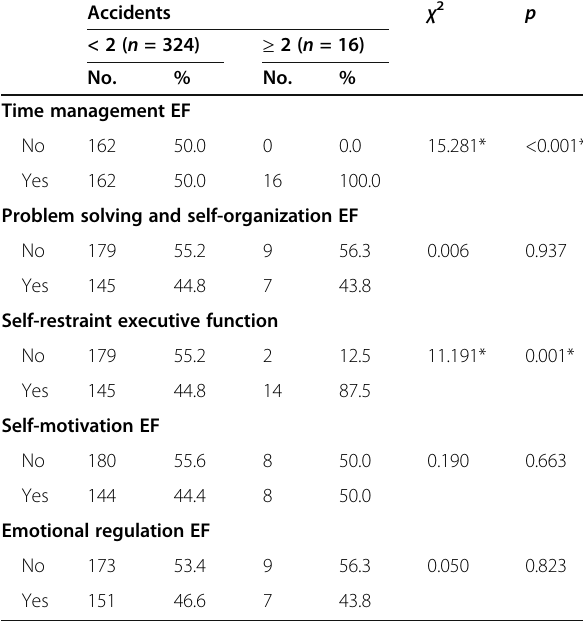
Table 4 Relation between accidents and executive function among the studied groups